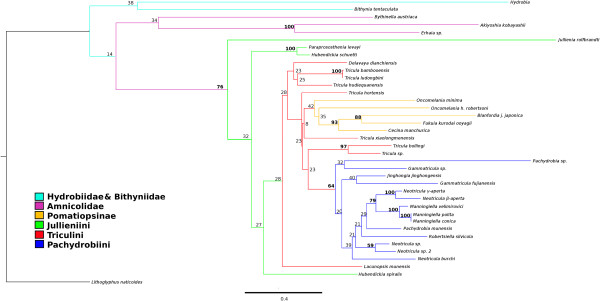
Best-scoring tree found by ML search with RAxML. Bootstrap support values are indicated on the tree as a percentage of 100000 replicates. Support values greater than 50% are shown in bold. The outgroup was set as Lithoglyphus naticoides. Colour scheme: Lacunopsini are classed with Triculini.